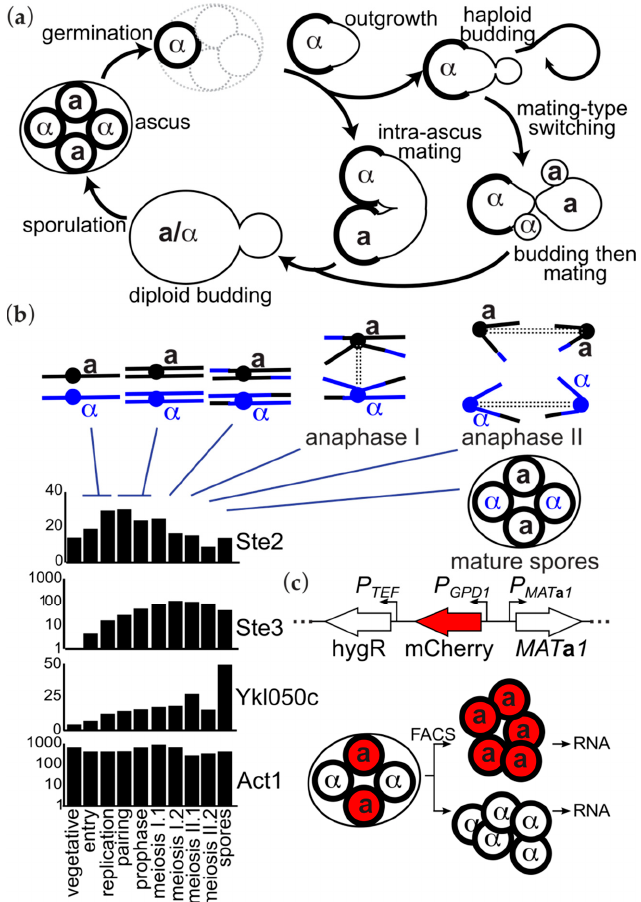
Figure 1. Early accumulation of mating ‐ type ‐ specific transcripts during S. cerevisiae and an approach to determine their inheritance in spores separated by mating type. ( a ) A simplified illustration of the life cycle of S. cerevisiae . Diploid cells undergo meiosis and sporulation, typically producing four haploid spores within each sporulating cell. Each spore is encased in a specialized wall (thicker lines) that confers resistance to a variety of environmental stressors. The two mating types, a and α , reflect alternative alleles at a single locus. Meiosis usually produces two pairs of spores of opposite mating types, which remain largely dormant until they germinate. After germination, spores can either bud or mate, often with another spore from the same ascus. Haploid budding can proceed indefinitely, or mating can occur at any point, given an appropriate partner. A haploid spore from most natural isolates is able to switch mating types and, via subsequent mating with one of its offspring, return to the diploid state. ( b ) Bar graphs show published data [6] with levels of the indicated transcripts as assessed by RNA-seq from cells taken at various time-points from synchronously-sporulating cultures. Major cellular events at each time-point are listed below and illustrated above, for a single representative chromosome (Chr. III) that also harbors the mating-type locus near its centromere. Data represent composite values from two methods of synchronized sporulation. Note that some y axes are in log scale. The spore-autonomous gene YKL050C is shown as an example of the expression pattern expected for transcripts inherited only by the spores that inherit the encoding allele. ( c ) Illustration of the FASTER-MT method [7] for isolating a and α spores via fluorescence- activated cell sorting (FACS). The spore-autonomous GPD1 promoter drives expression of mCherry and is inserted at the mating-type locus with the a allele, encoding Mat a 1. “hygR”, the hygromycin-resistance gene hph under control of the heterologous TEF promoter. Illustration is not to